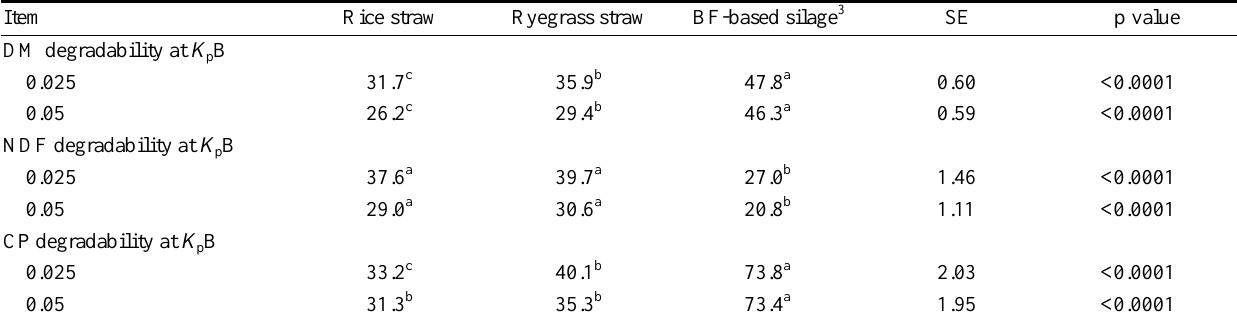
Table 5. The in situ dry matter (DM), crude protein (CP) and neutral detergent fiber (NDF) degradabilities at 2 rates of passage 1, 2 Item Rice